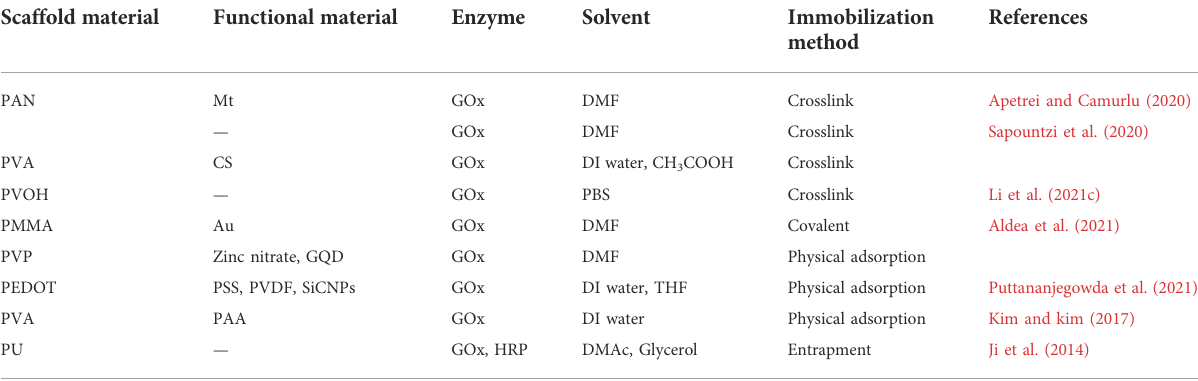
TABLE 4 Enzyme immobilization methods and materials in enzymatic electrospun NF-based biosensors. Scaffold